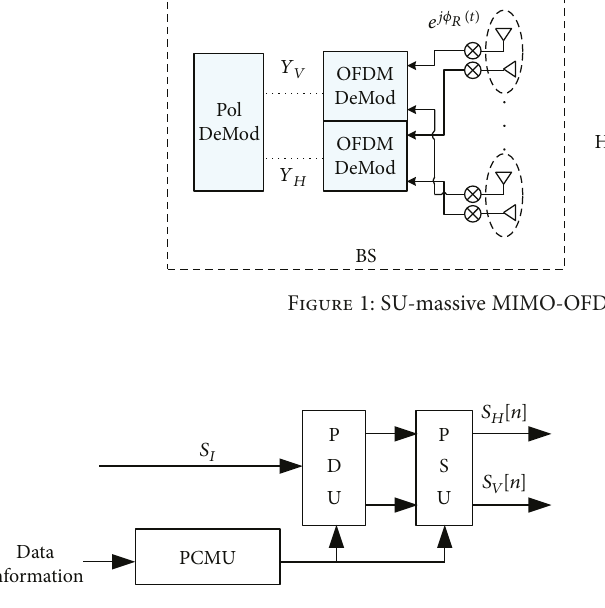
Figure 2: Polarization modulation unit. PCMU: polarization constellation mapping unit; PDU: power division unit; PSU: phase shifting